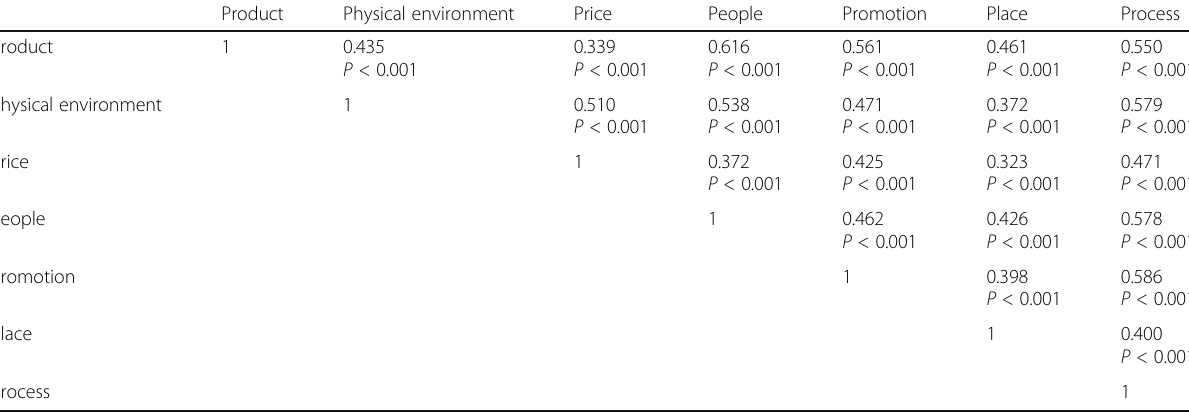
Table 6 Correlation between marketing mix in selected hospitals